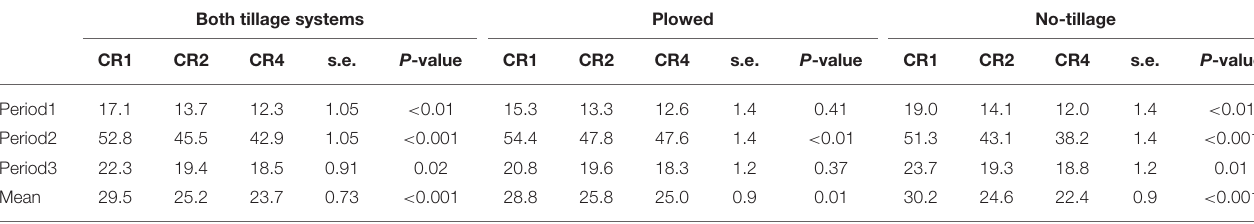
TABLE 9 | The average amount of kernels damaged by wheat midge in spring wheat in different tillage systems, time periods, and crop rotations. Both tillage systems Plowed No-tillage CR1 CR2 CR4 s.e. P -value CR1 CR2 CR4 s.e. P -value CR1 CR2 s.e. P -value Period1 5.6 NA Period2 Period3